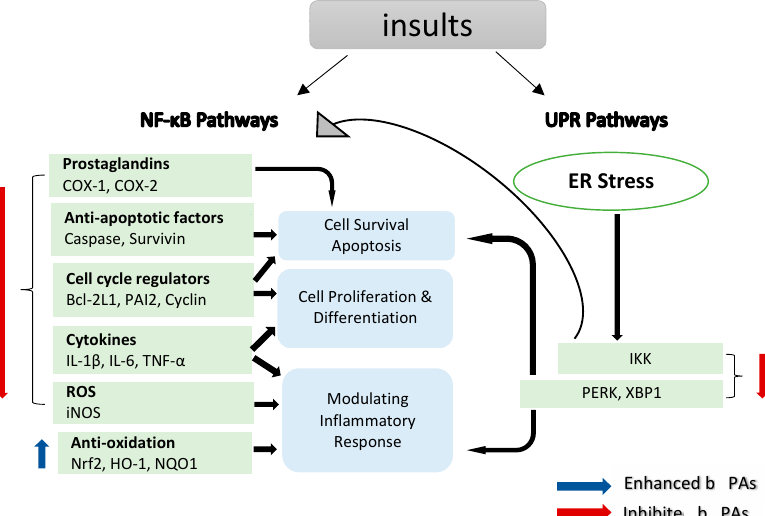
Figure 2. NF- κ B target genes implicated in the onset and progression of inflammation. NF- κ B is a transcription factor that is inducible. After activation, it can regulate inflammation by activating the transcription of several genes. NF- κ B regulates cell proliferation, apoptosis and differentiation in addition to promoting the production of pro-inflammatory cytokines and chemokines. Endoplasmic reticulum (ER) stress results in an inflammatory unfolded protein response (UPR). Stress on the ER induces apoptosis by activating inflammation. This can be accomplished by stimulating IKK complex (element of the NF- κ B) or (X-box binding protein 1) XBP1 and (protein kinase R-like ER kinase) PERK through a mediator. These trigger the release of pro-inflammatory molecules, hence accelerating cell death.